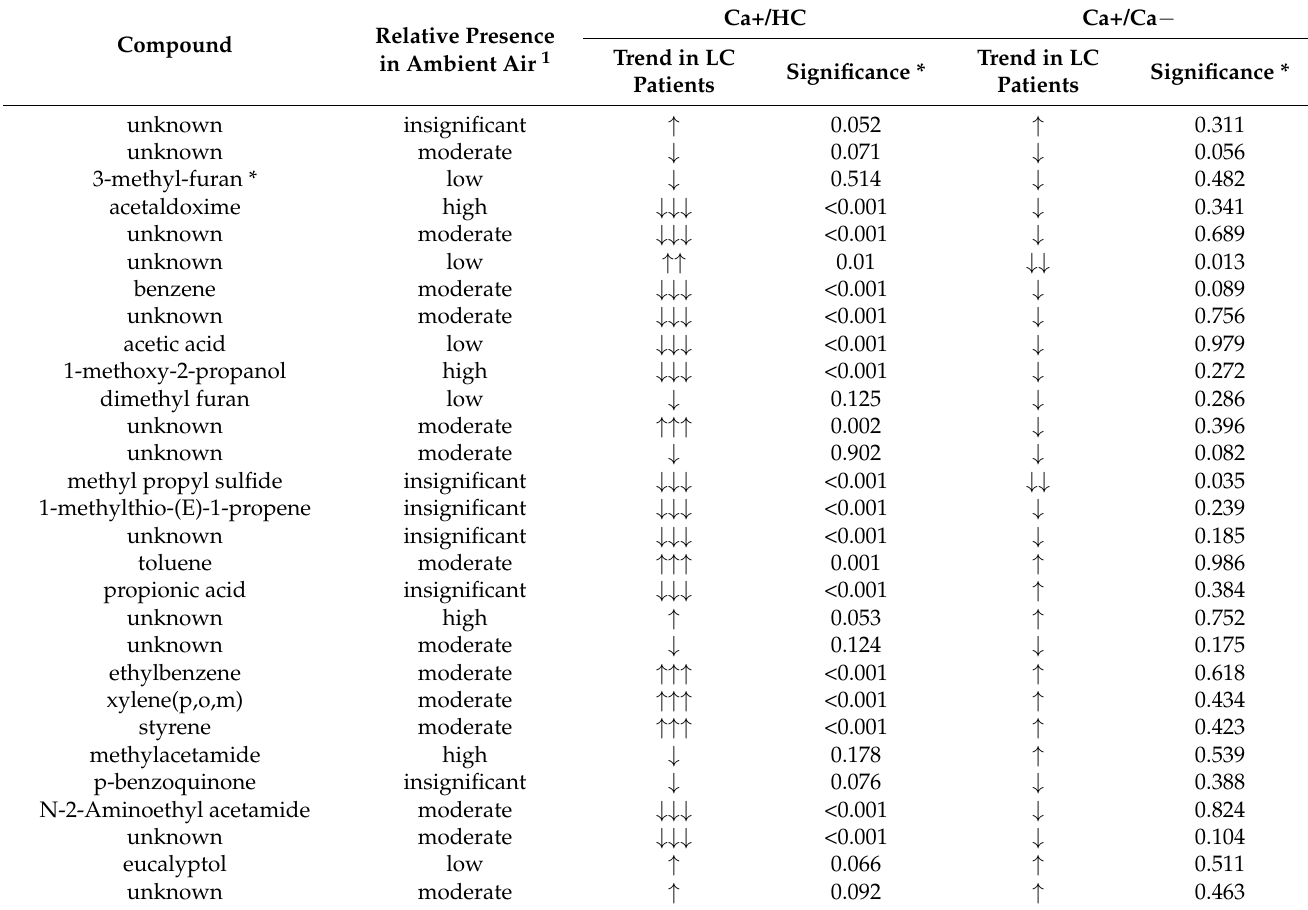
Table 2. Comparative analysis of the areas of the 29 chromatographic peaks between patient groups and relative presence in ambient